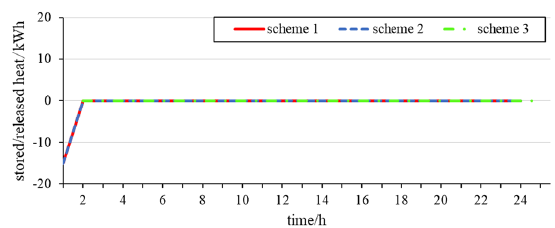
Fig. 13 Dynamic change of heat storage/release of the tank in winter